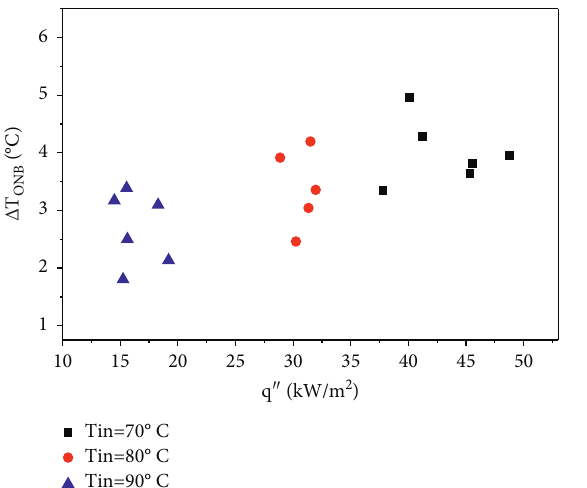
in channel a ( G : ONB